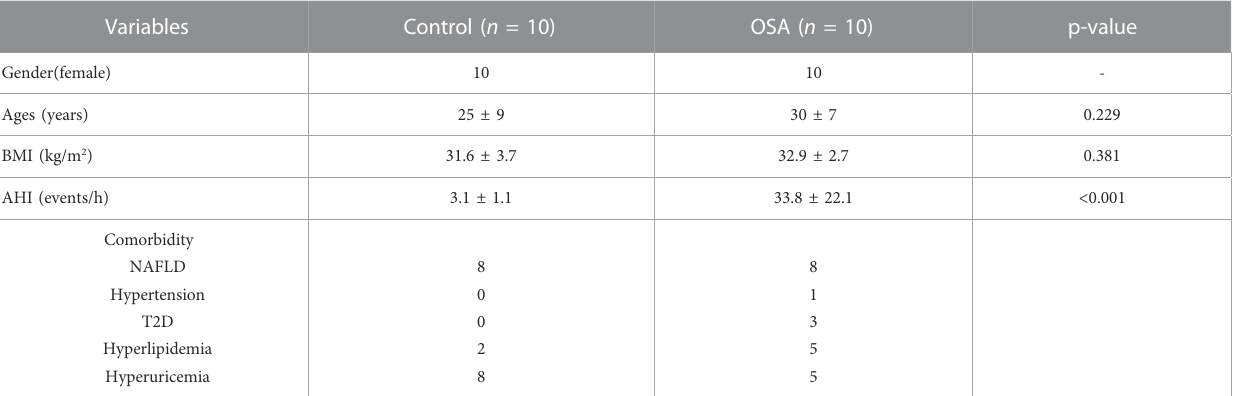
TABLE 1 The basic clinical characteristics of OSA patients and